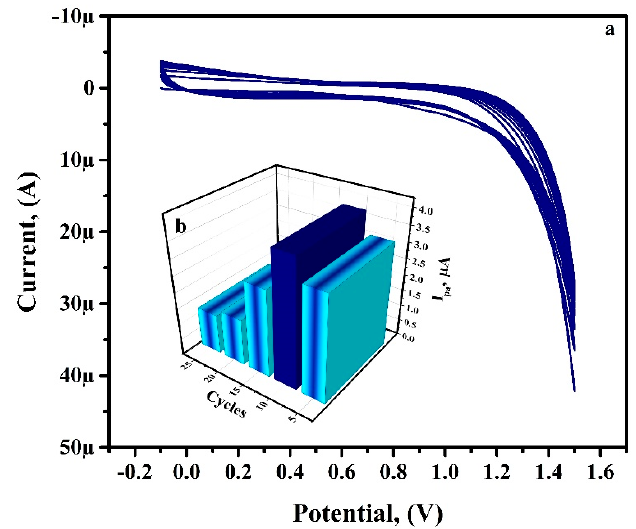
Figure 4. ( a ) CVs of electrochemical polymerisation of GA (0.1 mM) in 0.2 M PB of pH 6.5 in the potential window − 0.1 V to 1.5 V at ʋ = 0.1 V/s. ( b ) Plot of the I pa of 0.1 mM GA versus the number of polymerisation cycles.